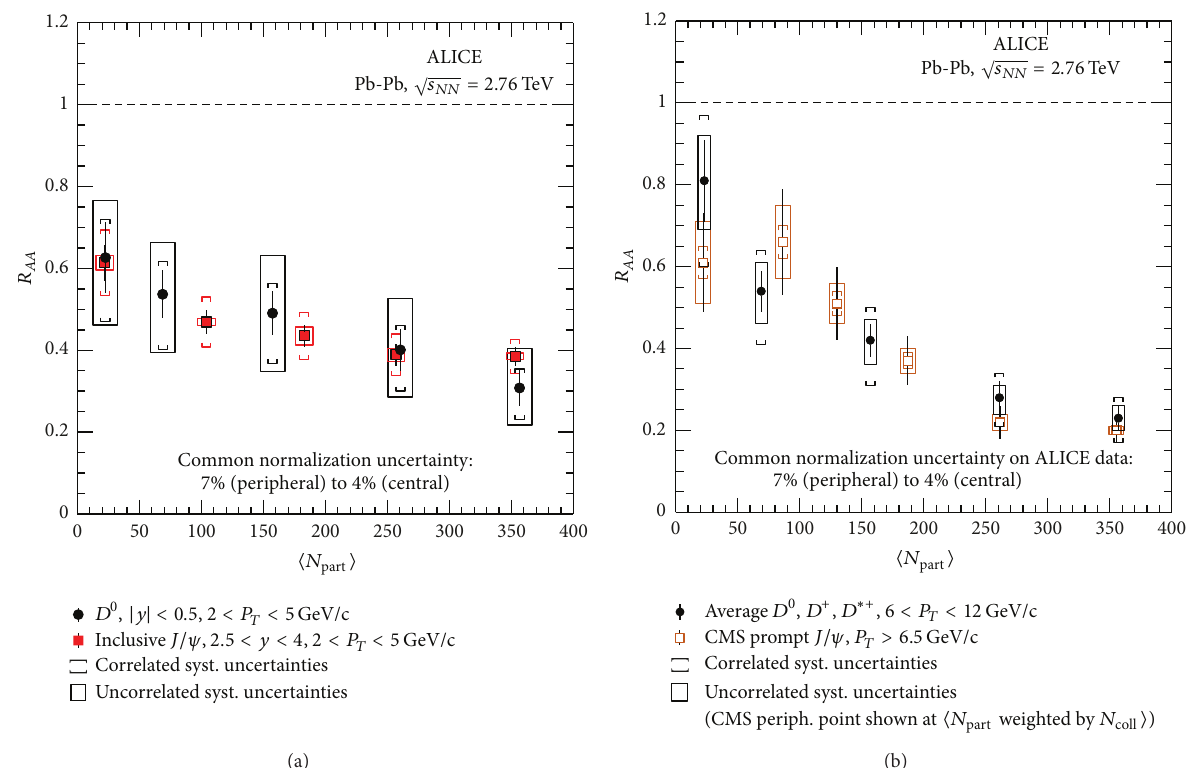
Figure 4: LHC data from ALICE and CMS [26–28], comparing 𝐽/𝜓 production to open charm production at intermediate (a) and high (b) transverse